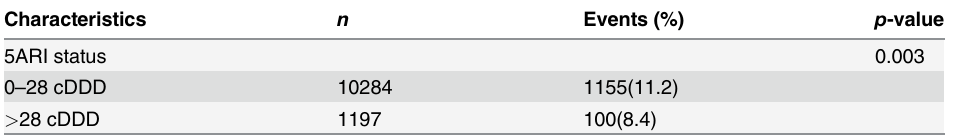
Table 2. The 5-year cumulative rate of cardiovascular diseases in those receiving and not receiving 5-alpha reductase inhibitor therapy. Characteristics